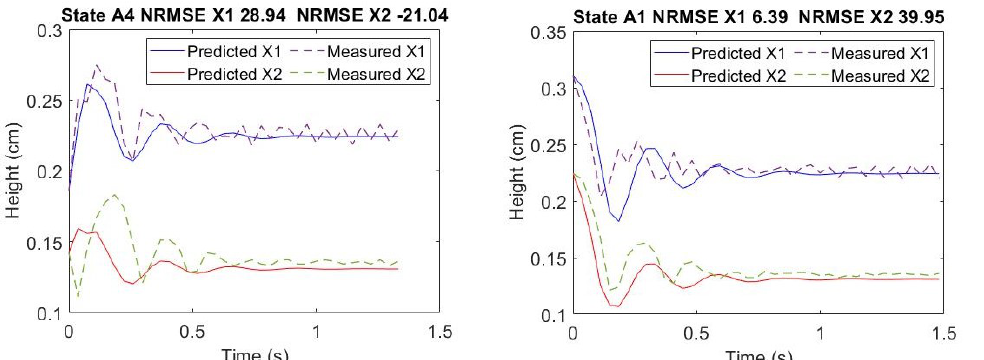
Figure A4. Misclassified profiles.